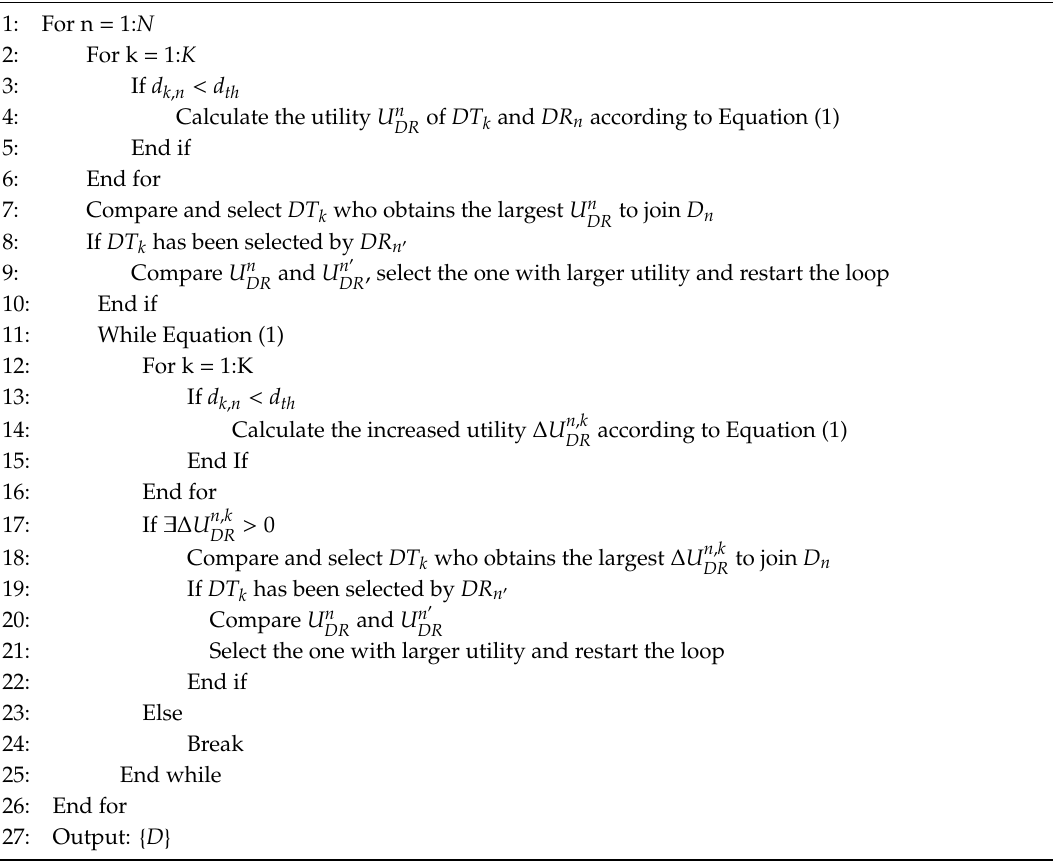
Algorithm 1 D2D cluster formation